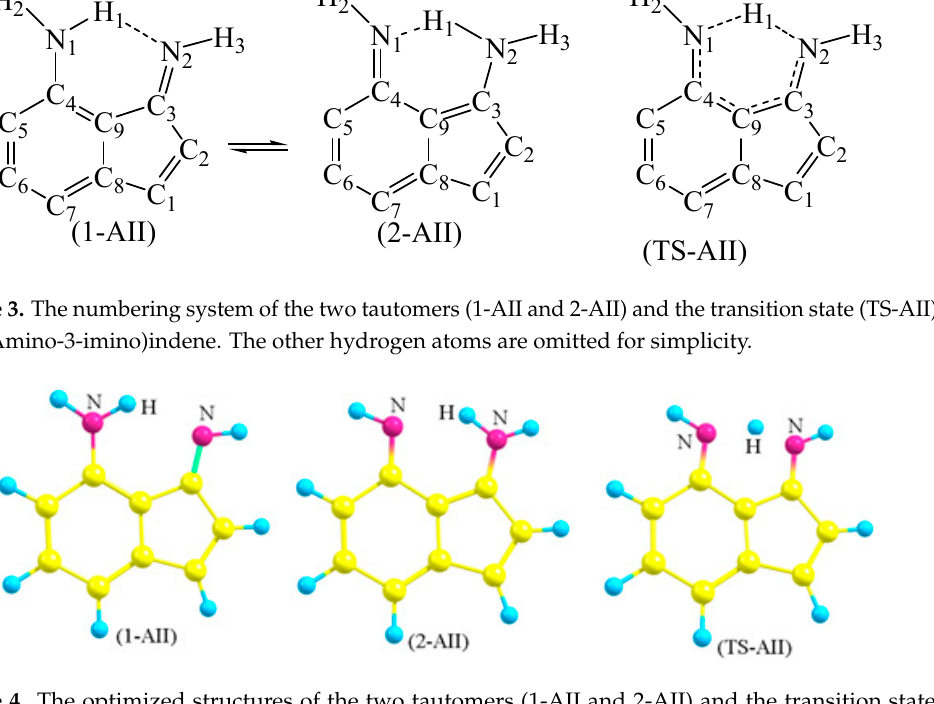
Figure 4. The optimized structures of the two tautomers (1-AII and 2-AII) and the transition state (TS-AII) of (4-Amino-3-imino)indene.